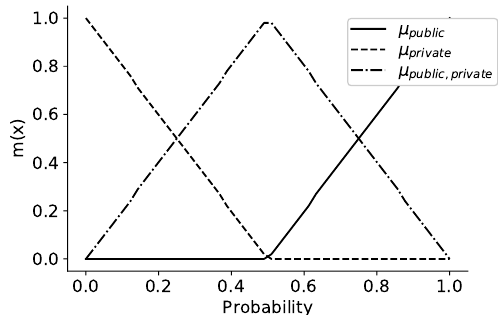
Figure 6. Basic probability assignment to convert the posterior probabilities of the public accessibility model to beliefs, which subsequently can be fused with the belief about greenness using the Dempster– Shafer